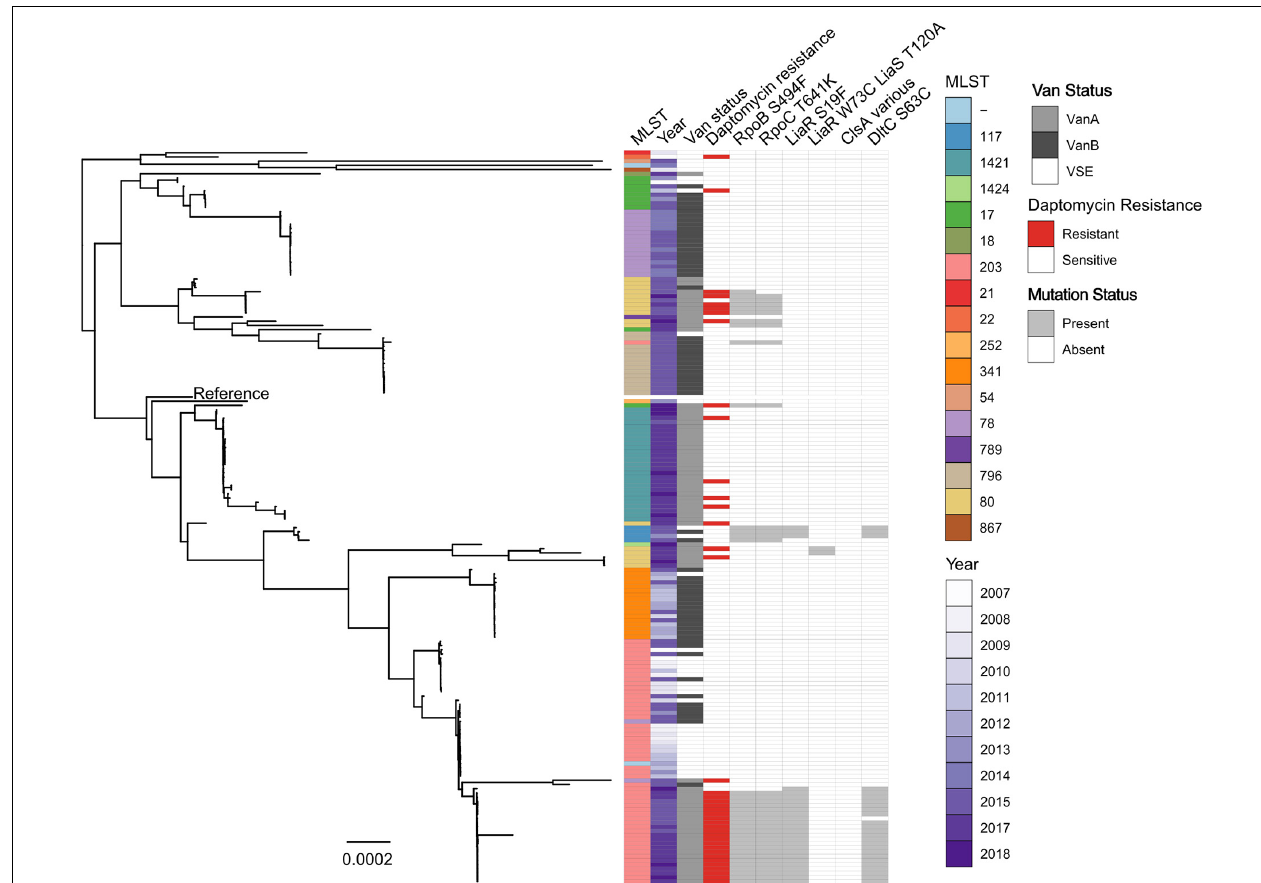
FIGURE 3 | Maximum likelihood core-SNP phylogeny of 173 Australian E. faecium study isolates. Coloured blocks show the multi-locus sequence type (MLST), country of origin (country), year of isolation (year), van status (i.e., vanA , vanB , and VSE) and daptomycin status (resistant or susceptible) for each isolate within the phylogeny. Grey blocks show the presence of the RNAP β -subunit S494F mutation (RpoB S494F), the RNAP β (cid:48) -subunit T641K mutation (RpoC T641K), the LiaR S19F mutation, the DltC S63C mutation, the LiaR W73C and LiaS T120A co-occurring mutations or mutations within ClsA previously associated with daptomycin resistance in VREfm (ClsA various) for each isolate within the phylogeny. The vanA -VREfm strain D0 (TX16) (Diaz et al., 2014) was used as the